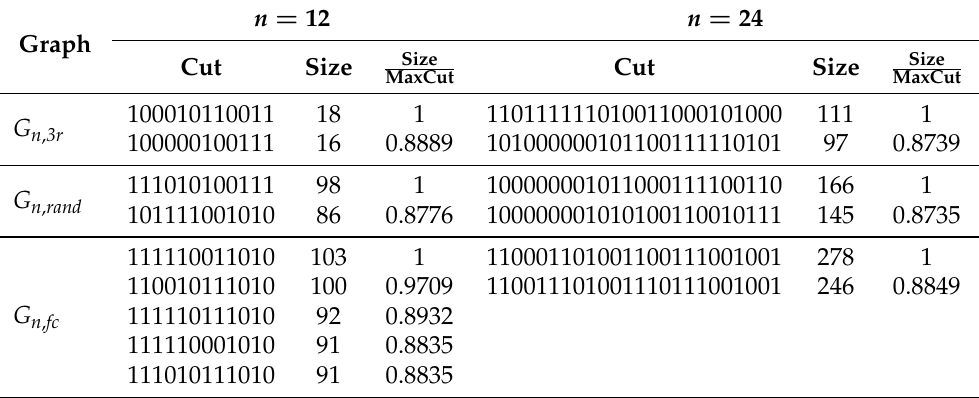
Table 1. Cuts and MaxCuts of the graphs in Figure 3. Cuts are represented as bit strings as described in Section 3. Those for 12-node graphs are given in the left-hand side and those for 24-node graphs in the right-hand side of the table alongside the cut size and respective ratio of the